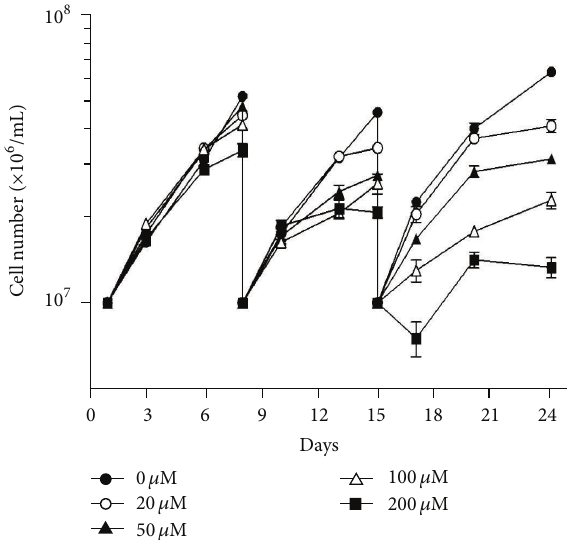
Figure 7: Effect of levothyroxine on T. cruzi epimastigotes prolifera- tion. To determine the growth rate, 10 7 cells/mL were seeded in BHT medium and cultured at 28 ∘ C with the indicated concentrations of the drug; the control condition was done with 0 𝜇 M levothyroxine, 2% DMSO. Parasites were counted daily using a hemocytometer chamber and, once they reached the stationary phase, were rediluted at 10 7 cells/mL with fresh medium plus the indicated levothyroxine concentration. Results represent the mean ± SD of a representative